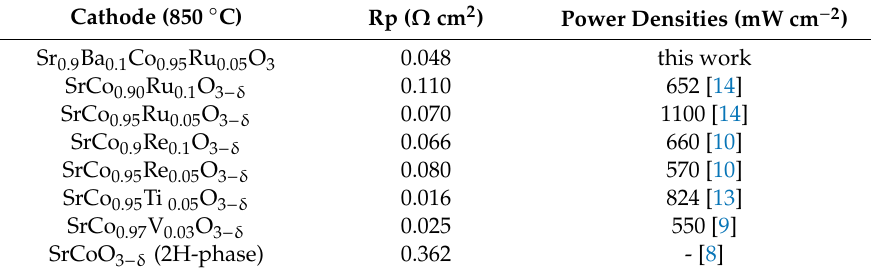
Table 2. Polarization resistances and power densities (with H 2 as a fuel) of di ff erent cathodes. For the sake of comparison, values of undoped SrCoO 3 − δ (2H phase) are also given. For the Power Densities, LSGM and SrMo 0.8 Fe 0.2 O 3 − δ perovskite were used as electrolyte and anode material, respectively. For the 2H phase, no power density magnitude was